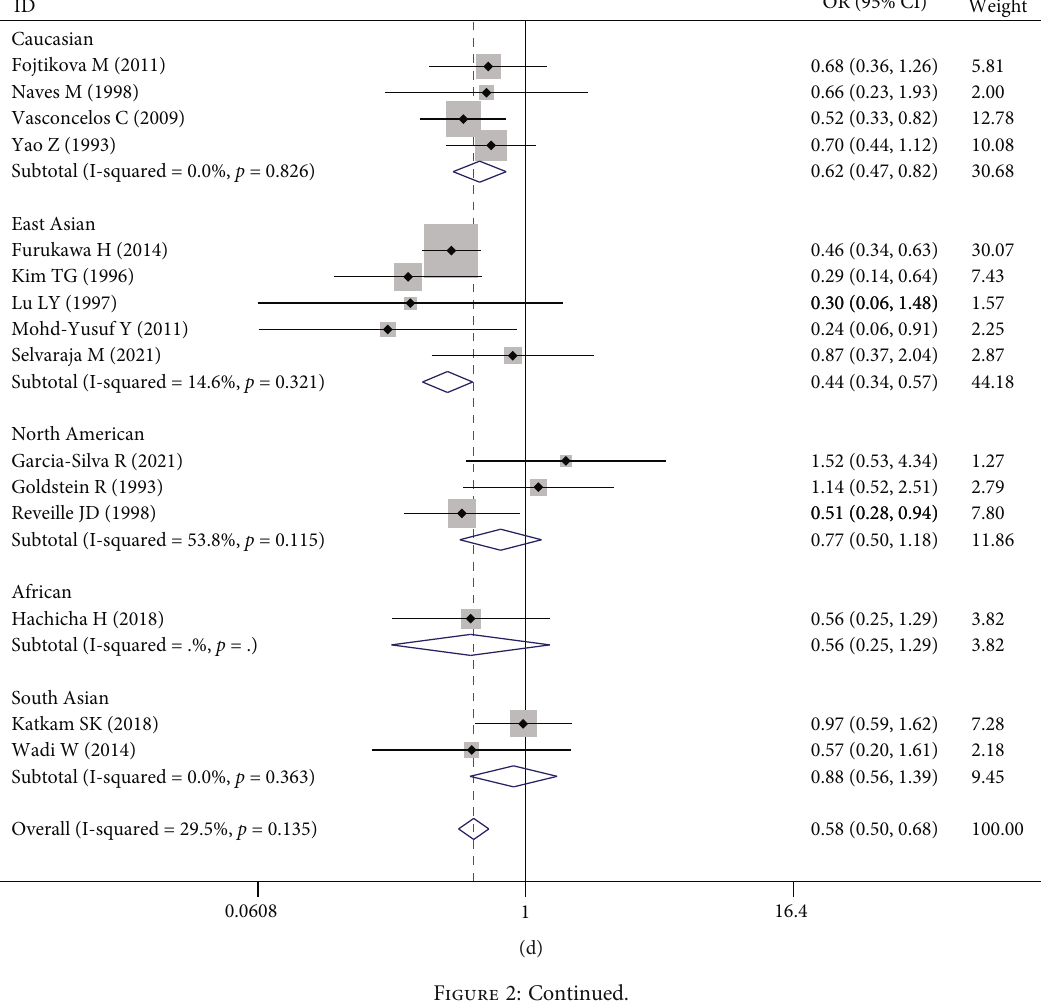
0.135)Subtotal (I-squared = 14.6%, p =